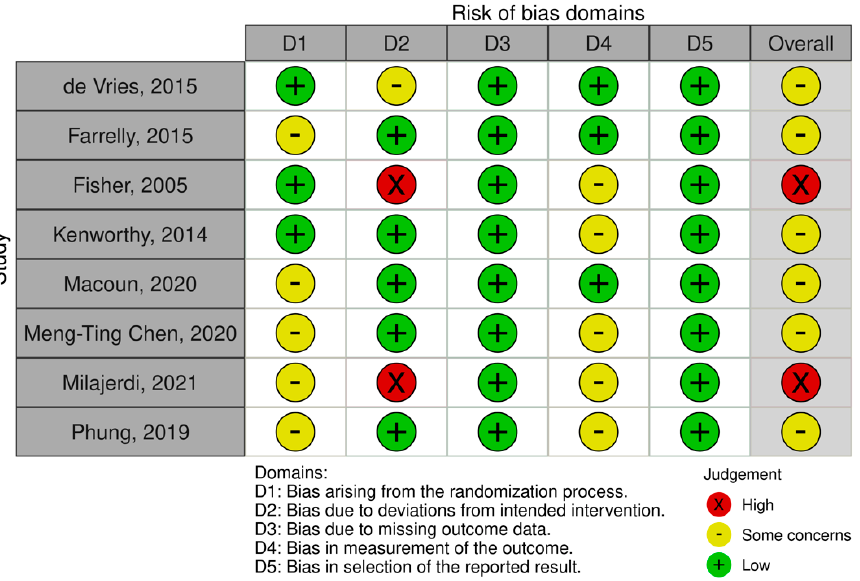
Figure 2. Risk of bias in randomized control trials studies (RCTs) included in this review (green: low bias risk; yellow: some concerns; red: high bias risk).